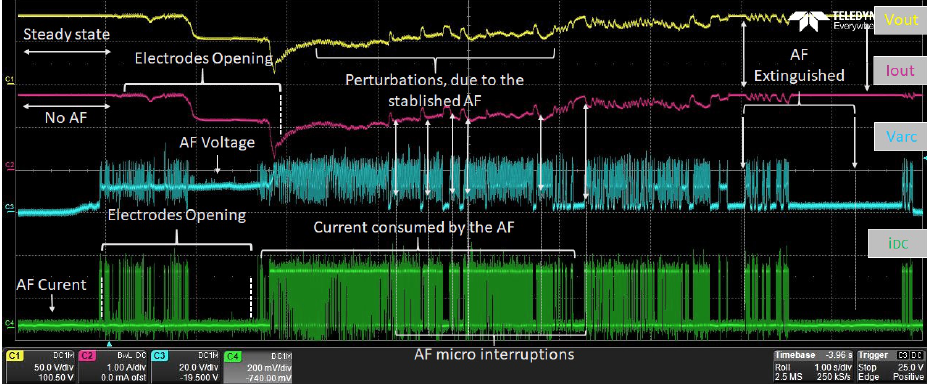
Figure 11. Conventional DC/DC boost converter behavior, before and after an AF. Power Converter under AF-DC/AC Converter